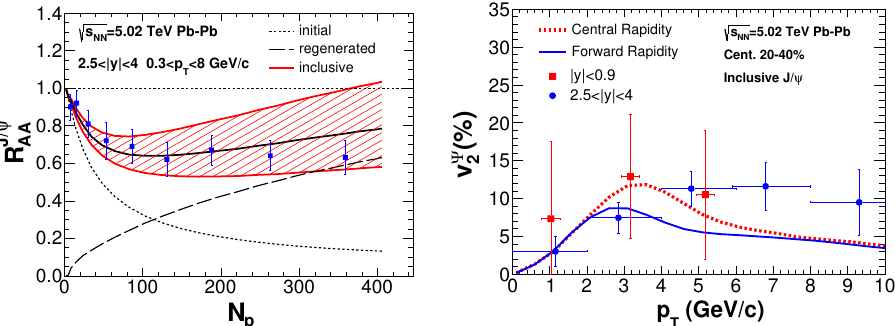
Figure 4. ( Left ) J / ψ nuclear modification factor R AA as a function of number of participant N p √ s NN = 5.02 TeV Pb-Pb collisions. Dotted, dashed and solid lines represent the primordial at production, regeneration and inclusive production, respectively. The band corresponds to the uncertainty in the production cross-section of charm pair d σ c ¯ c pp / dy . ( Right ) Elliptic flows of inclusive J / ψ as a function of p T in centrality 0–20%. This figure is cited from Ref.